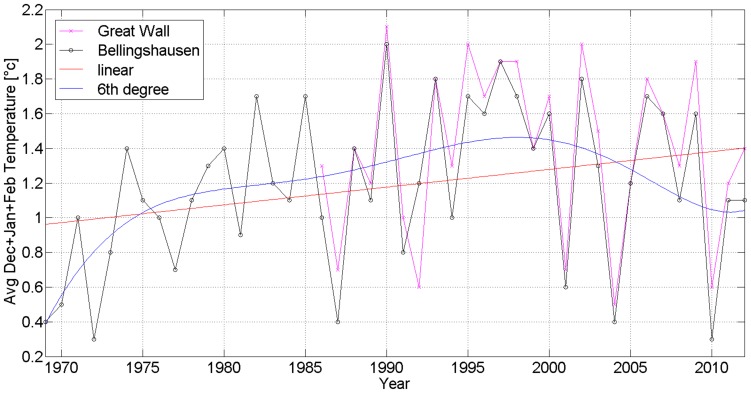
The average summer monthly temperature (December, January and February) at Station Bellingshausen and Great Wall Station on Fildes Peninsula, Antarctica, by using MATLAB and calculating with linear and 6th degree [55], [56].